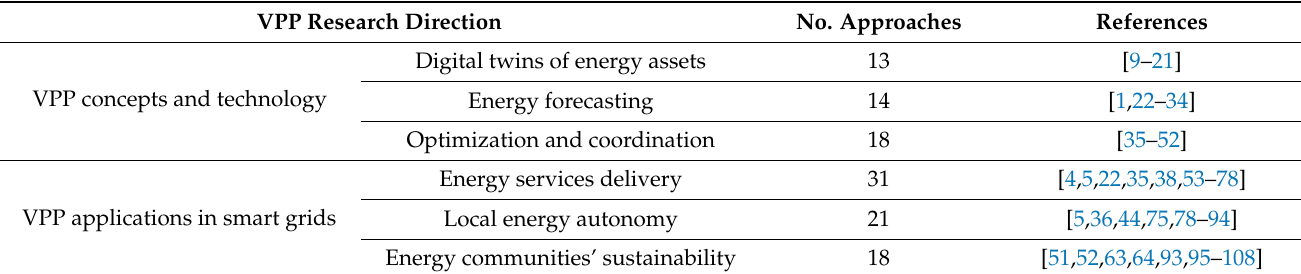
Table 2. Narrative review research directions studied.